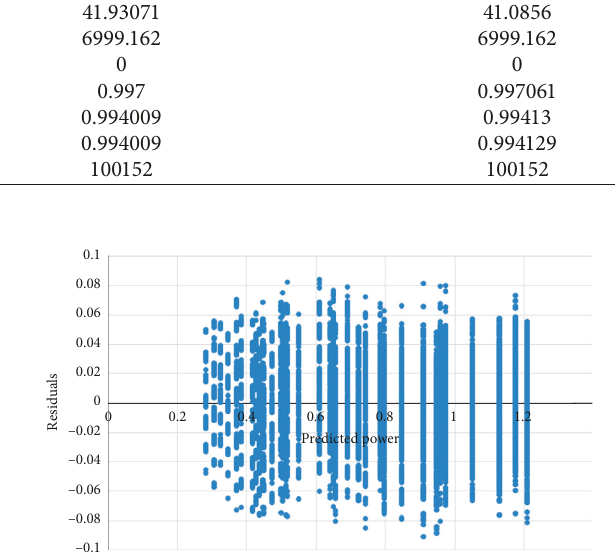
Figure 7: Residual plot for the full-quadratic regression model.